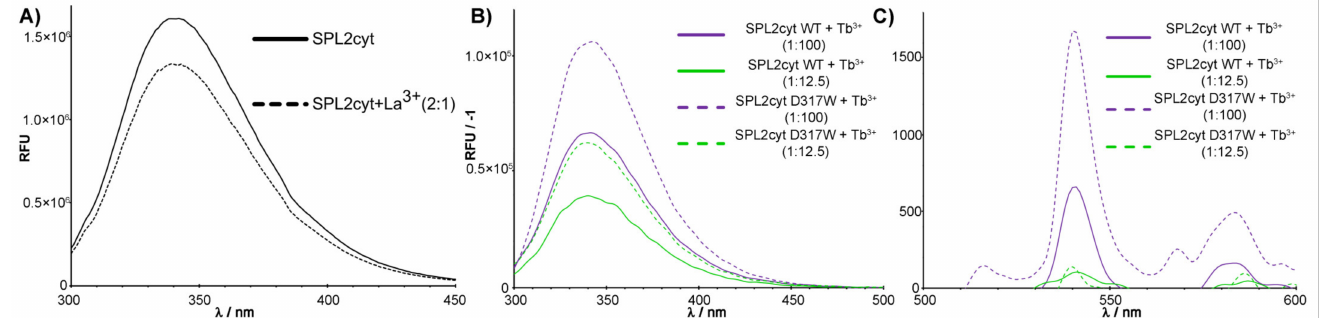
Figure 2. Fluorescence spectra in the presence of different Ln ions. ( A ). Tryptophan fluorescence spectra of 2 µ M SPL2cyt in the absence (dotted line) and presence (solid line) of La 3+ at indicated molar ratios. ( B ) Normalized tryptophan fluorescence spectra and ( C ) normalized terbium luminescence spectra of 2 µ M SPL2cyt (WT) and its mutant (D317W) in the presence of Tb 3+ at indicated molar ratios. Each spectrum was background-corrected for a protein-free buffer containing indicated concentrations of terbium